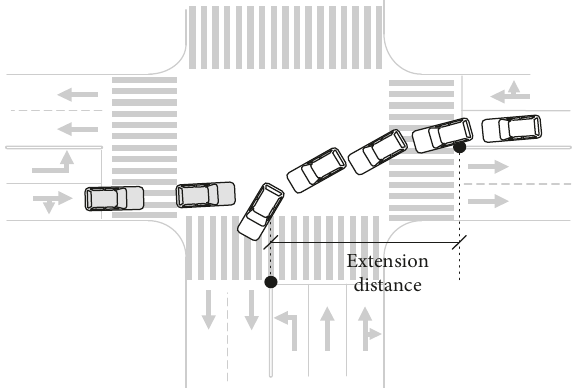
Figure 2: The definition of the extension distance.